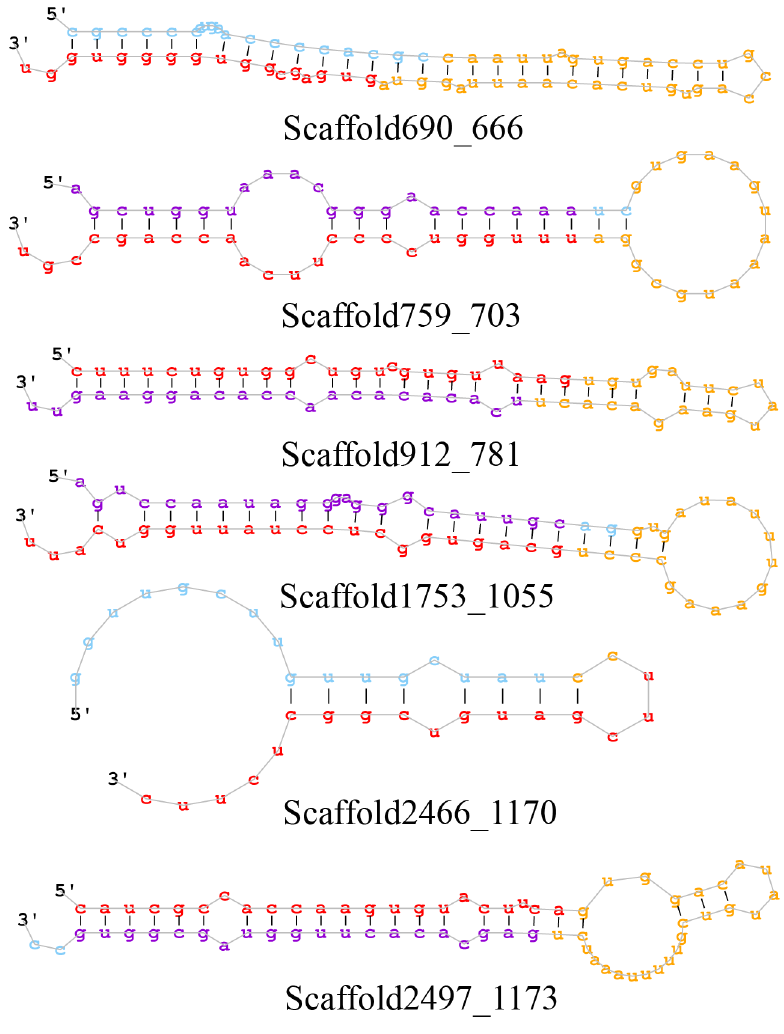
Figure 4. The secondary structure of predicted novel miRNAs.